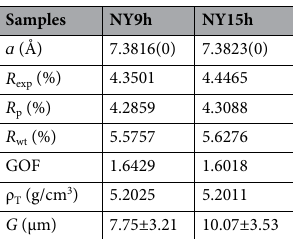
Table 2. Structural data obtained from the Rietveld refinement, theoretical density (ρ T ), and mean grain size (G) for the NY9h and NY15h ceramics.